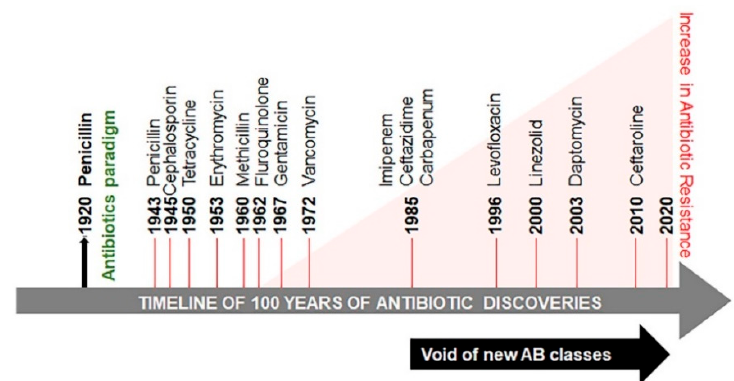
Figure 1. Timeline of antibiotic discovery and its onset of resistance. The antibiotic paradigm emerges out of the followed discovery of penicillin. Between the 1960s and the 1980s there was a surge in the discovery of antibiotics, but this development declined between the 1980s and the 1990s. The identification of new antibiotic classes by pharmaceutical companies has stagnated since 1987 and coincided with progressively increased antibiotic resistance and mortality related to antibiotic- resistant infections.